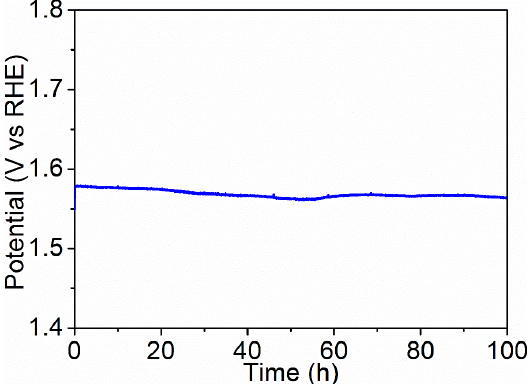
Figure 6. Potential trace of the Ni 75 Ce 25 O x sample obtained by fixing the current density for electrolysis at 10 mA/cm 2 . The electrolyte was 1 M KOH (pH ≈ 14).